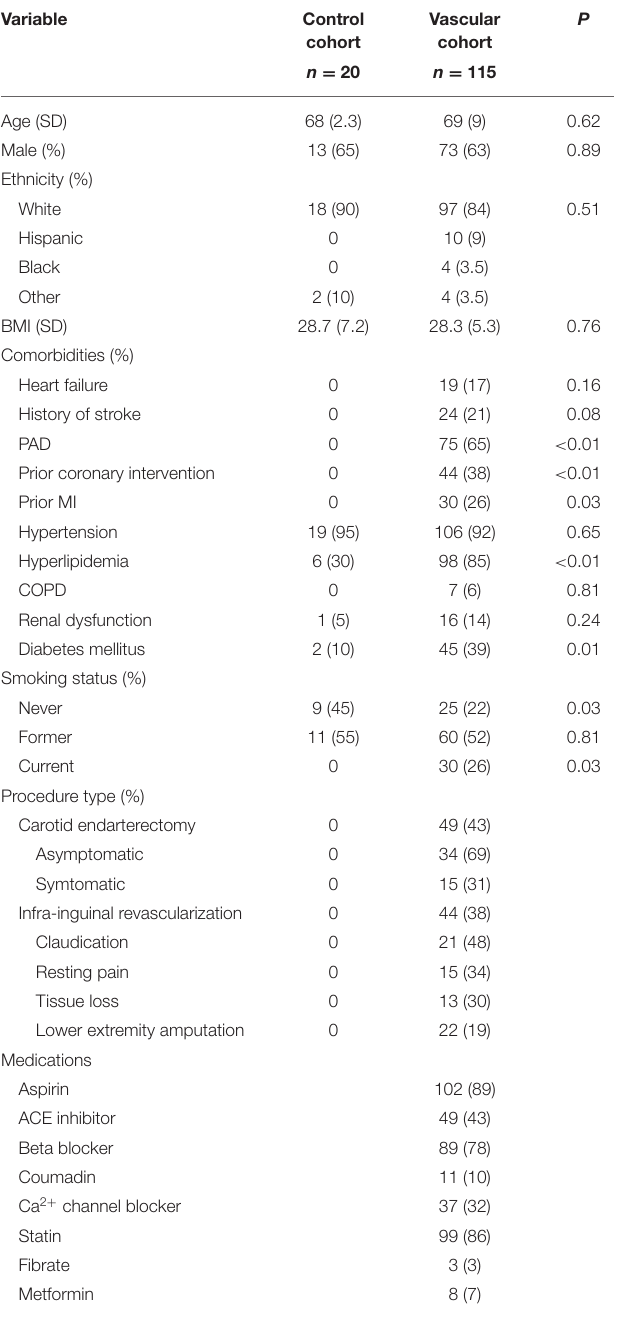
capacity compared to vascular disease patients ( Figure 1A